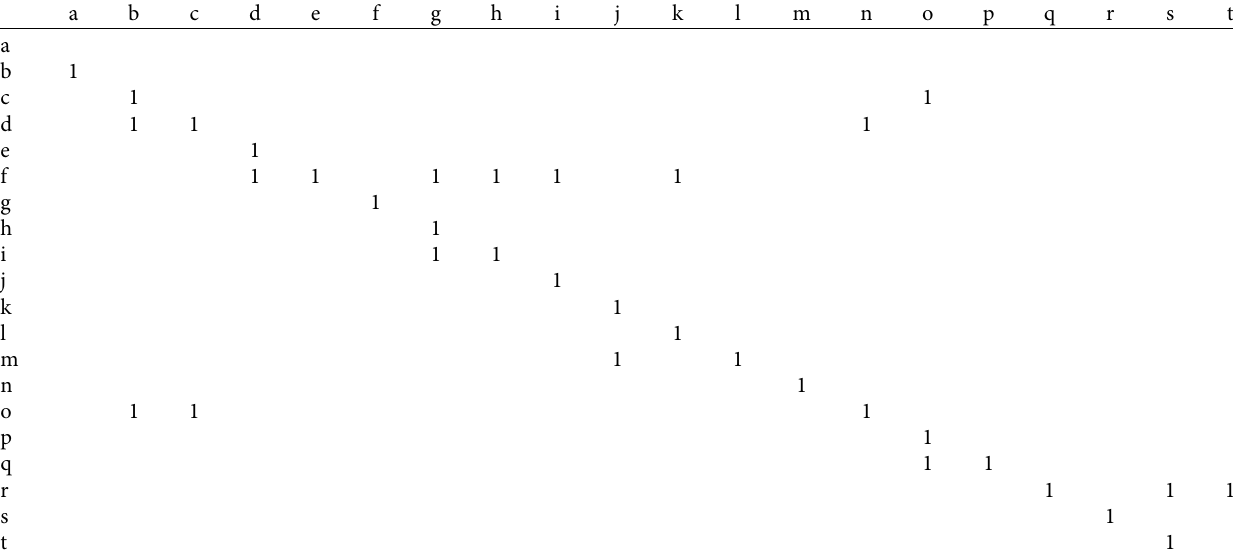
Table 5: Initial DSM of the convenience store